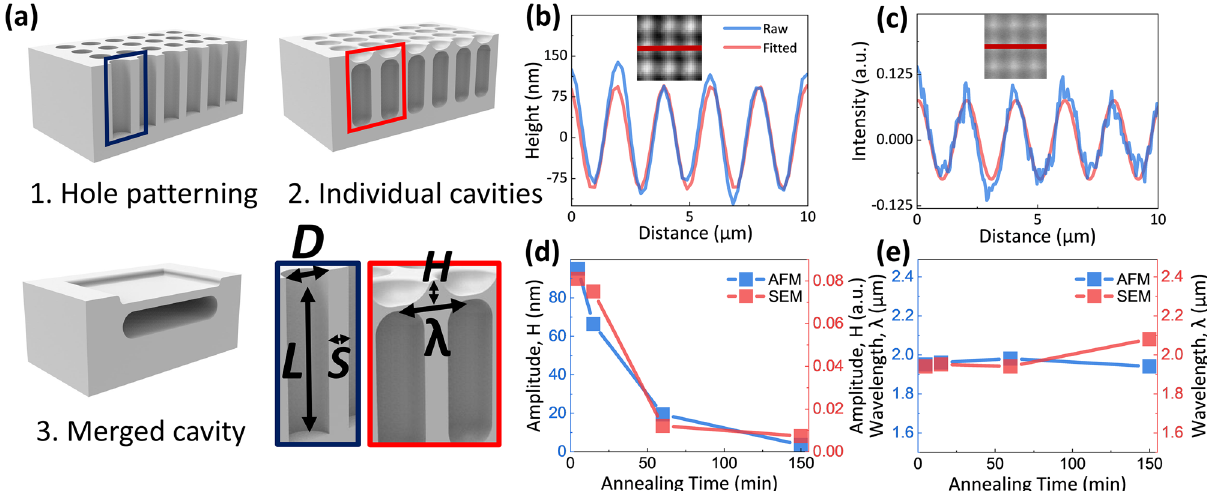
Figure 1. ( a ) The shape evolution process of the GON structure. As shape evolution proceeds, the height and spacing of the cavity changes, and steps and periodic structures are formed on the surface. Length ( L ) and diameter ( D ) are used to calculate the aspect ratio ( L/D ), and height ( H ) and period or wavelength ( (cid:31) ) to quantify the surface profile transformation over time. ( b ) AFM and ( c ) SEM images of periodic morphology formed on the surface of 5 min annealed GON structures and their sinusoidally fitted profile. The sinusoidal signal is zeroed by subtracting its temporal average. ( d ) Change in amplitude ( H from a ) of the sinusoidal fits over increasing annealing time. ( e ) Change in wavelength ( (cid:31) from a ) of the sinusoidal fits over increasing annealing